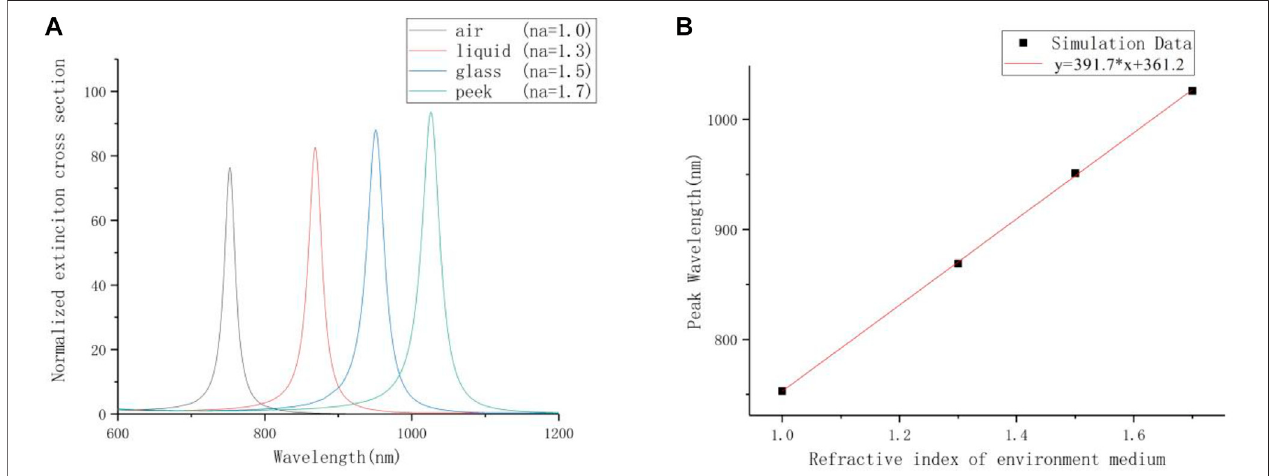
FIGURE 6 | (A) The extinction spectrum with different environmental media. (B) The relationship between the refractive index of the environmental media and the resonance peak.